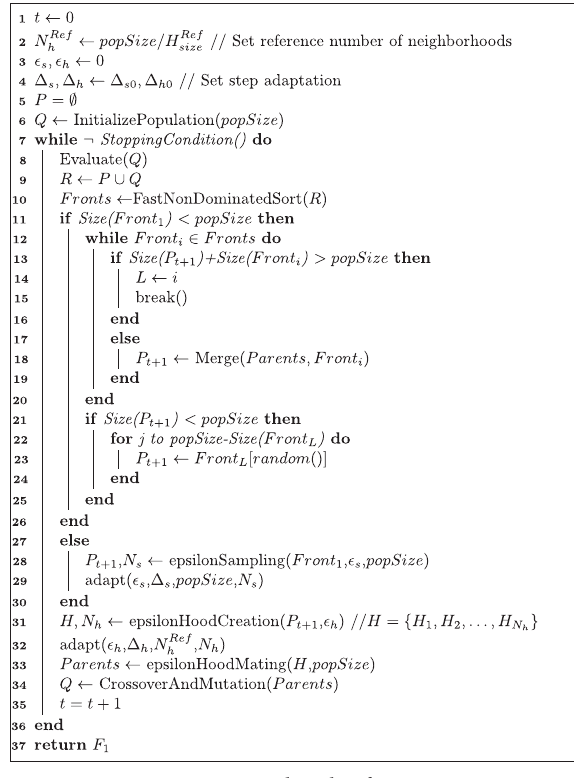
Figure 9: Pseudocode of A ϵ S ϵ H.